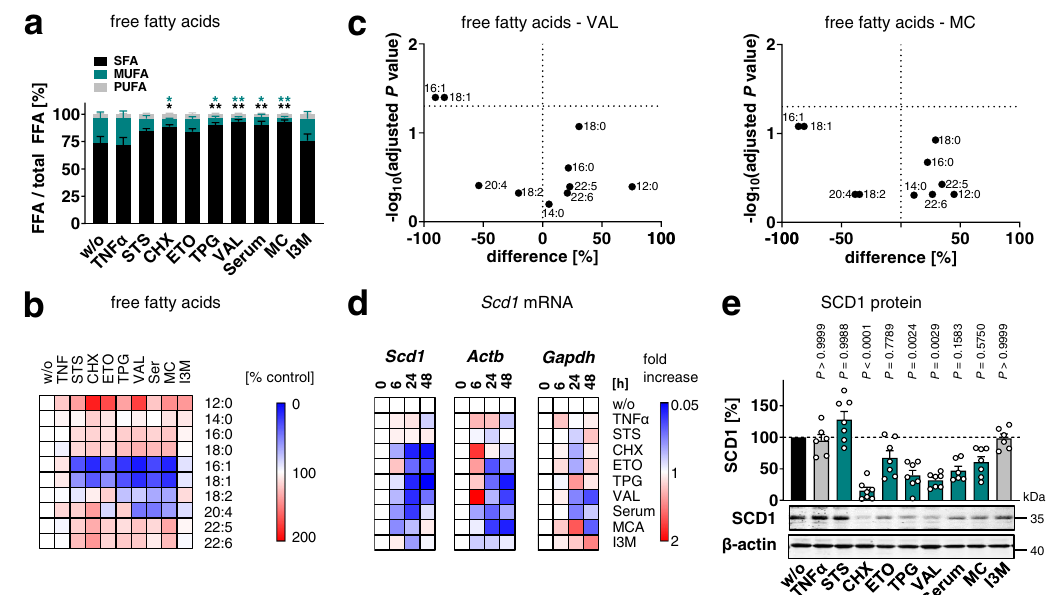
Fig. 3 SCD1 expression decreases during preparation for cell death. Fibroblasts were cultivated under diverse cytotoxic conditions for 48 h ( a – c , e ) or as indicated ( d ). a Cellular proportion of non-esteri fi ed SFAs, MUFAs, and PUFAs. SFAs: 12:0, 14:0, 16:0, 18:0; MUFAs: 16:1, 18:1; PUFAs: 18:2, 20:4, 22:5, 22:6 (MUFA LTR P = 0.0146, 0.0128, 0.0023, 0.0155, 0.003; SFA LTR P = 0.0176, 0.0088, 0.0013, 0.0072, 0.0015). b Heatmap showing changes in the free fatty acid pro fi le as compared to vehicle control. Data are given as percentage of the relative free fatty acid abundance. c Volcano plots highlighting free fatty acids that are strongly and signi fi cantly modulated by VAL or MC. Comparisons of the indicated treatment groups show the mean difference of percentage changes and the negative log10(adjusted P value). Adjusted P values given vs. vehicle control; two-tailed multiple unpaired student t tests from log data with correction for multiple comparisons using a two-stage linear step-up procedure by Benjamini, Krieger, and Yekutieli (false discovery rate 5%). d Heatmaps showing the time-dependent effect on Scd1 , Actb , and Gapdh mRNA levels that were normalized to the total amount of cellular RNA and compared to vehicle control for each time point. e Protein expression of SCD1. Western blots are representative of seven independent experiments (LTR P = 0.000000002, 0 : (cid:1) 99). Mean ( b – d ) or mean + s.e.m. ( a ) and single data ( e ) from n = 2 ( d for Scd1 and Gapdh at 6 h; Actb at 48 h for Serum), n = 3 ( a – d ), n = 6 ( e for TNF α , Serum, I3M), n = 7 ( e ) independent experiments. * P < 0.05, ** P < 0.01 or P values given vs. vehicle control; repeated measures one-way ANOVA ( a ) or mixed-effects model (REML) of log data ( e ) + Tukey HSD post hoc